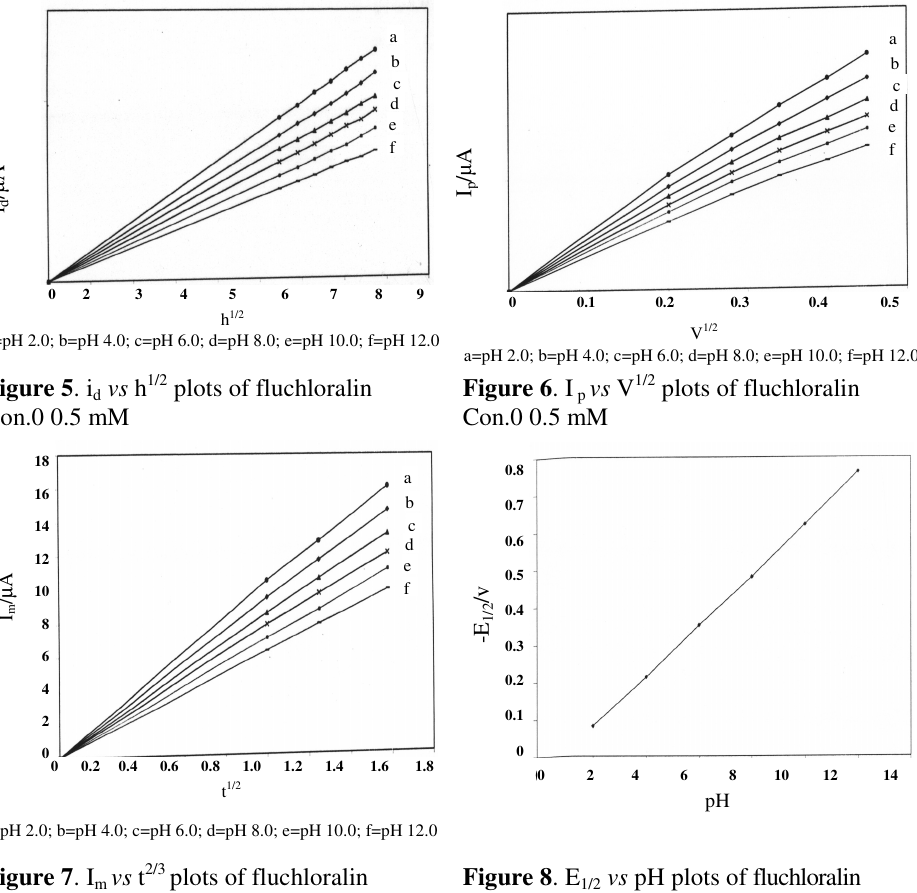
Figure 7 . I vs t 2/3 plots of fluchloralin m Con.0.5 mM